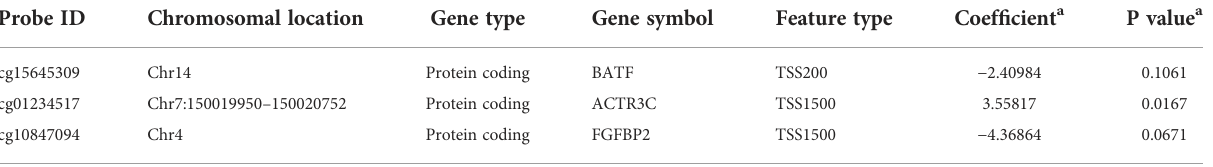
TABLE 3 Three cluster-related methylation sites in the prognostic signature analysis.